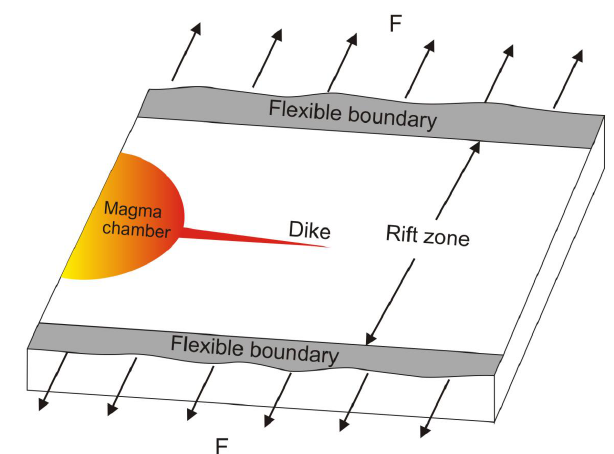
Fig. 13. Dike injected laterally from a magma chamber located in a volcanic edifice associated with a rift-zone segment. A flexible boundary means that the loading is constant during the dike emplacement - that is, the boundary can move as the dike propagates.